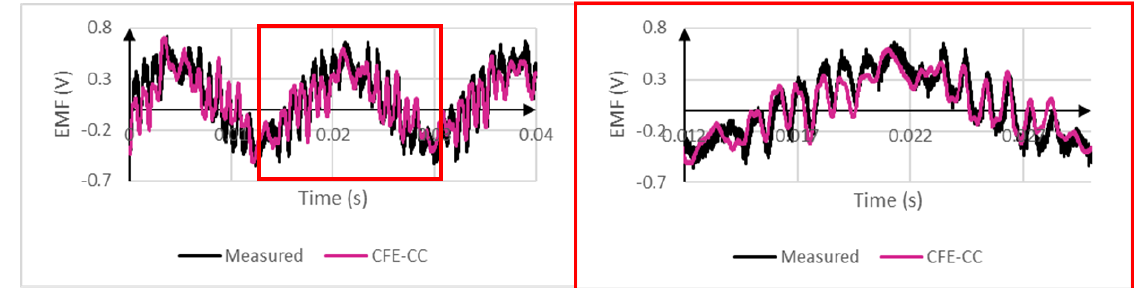
Figure 10. Search coil voltage during load operation, enlarged on right side.